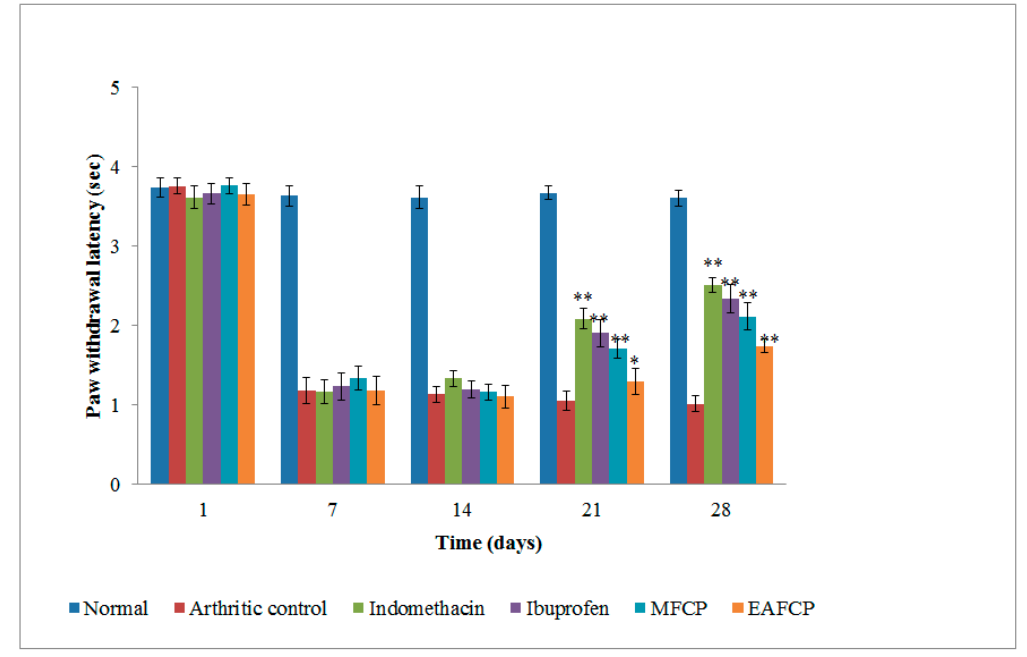
Figure 2. Measurement of paw withdrawal latency. Values are mean ± SEM for 6 animals; statistical analysis by one-way ANOVA followed by Dunnett test using Graphpad Instat software; * p < 0.05 and ** p < 0.01 when compared to arthritic control normal control.